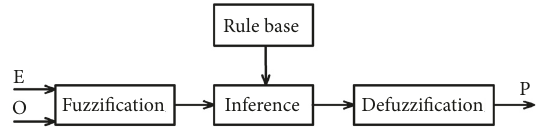
Figure 1: Architecture of the fuzzy controller.